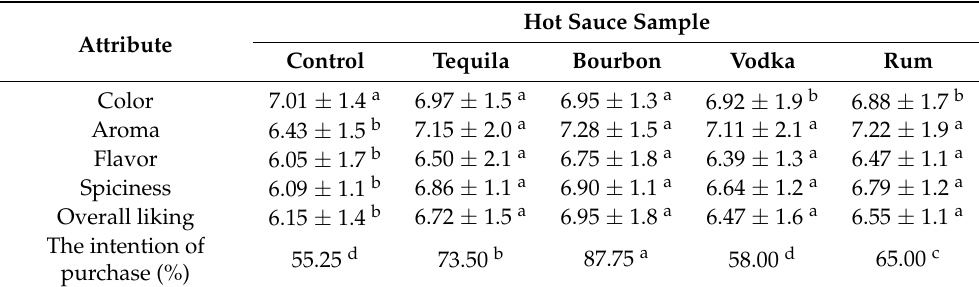
Table 3. Sensory scores and intention of purchasing hot sauces formulated with vinegar (control), tequila, bourbon, vodka, and rum.